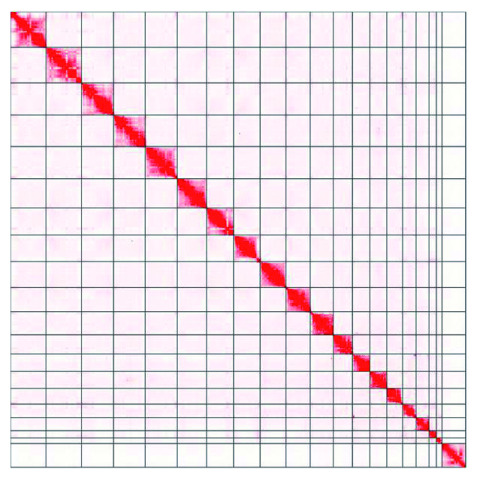
Genome assembly of
Sciurus vulgaris mSciVul1: Hi-C contact map.Hi-C contact map of the
S. vulgaris mSciVul1 assembly, visualized in Juicebox. The interactive version of this figure is available
here, powered by Juicebox.js (
Robinson
et al., 2018).